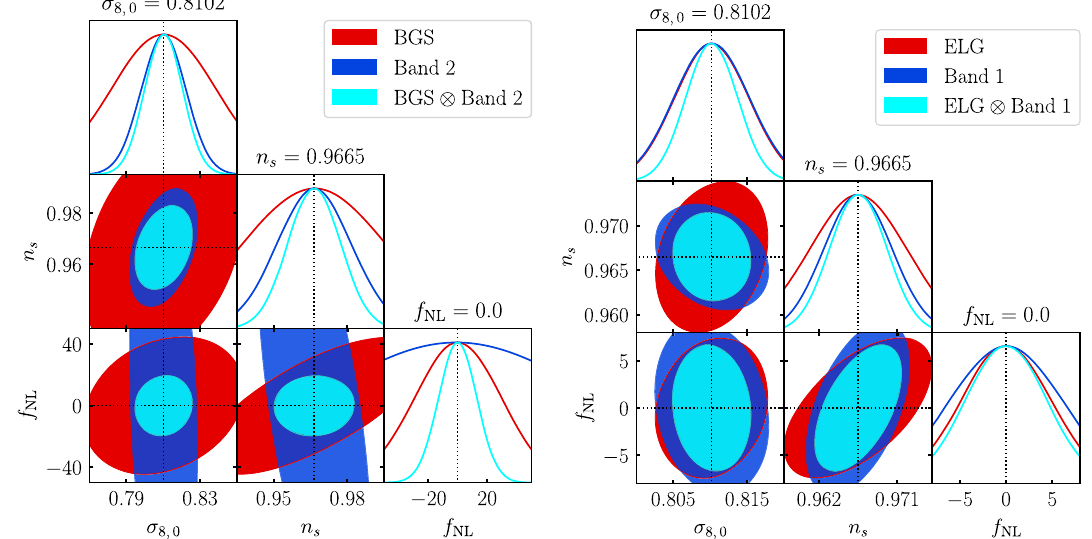
Fig. 4 1 σ contours, including foreground avoidance in HI intensity mapping and marginalising over bias parameters